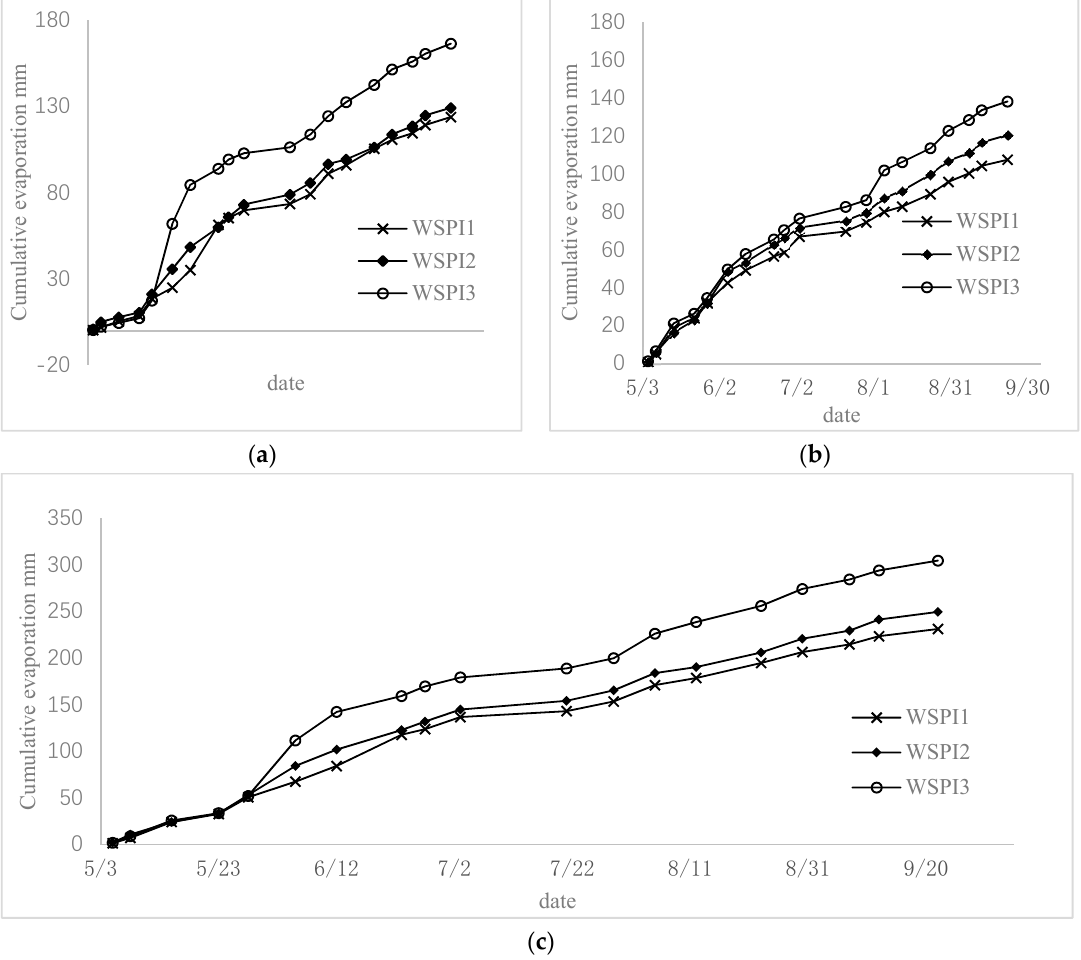
Figure 7. ( a ) Cumulative evaporation of surface soil under different irrigation treatments; ( b ) Cumulative evaporation of soil in water storage pits under different irrigation treatments; ( c ) Total cumulated evaporation of soil under WSPI by different irrigation